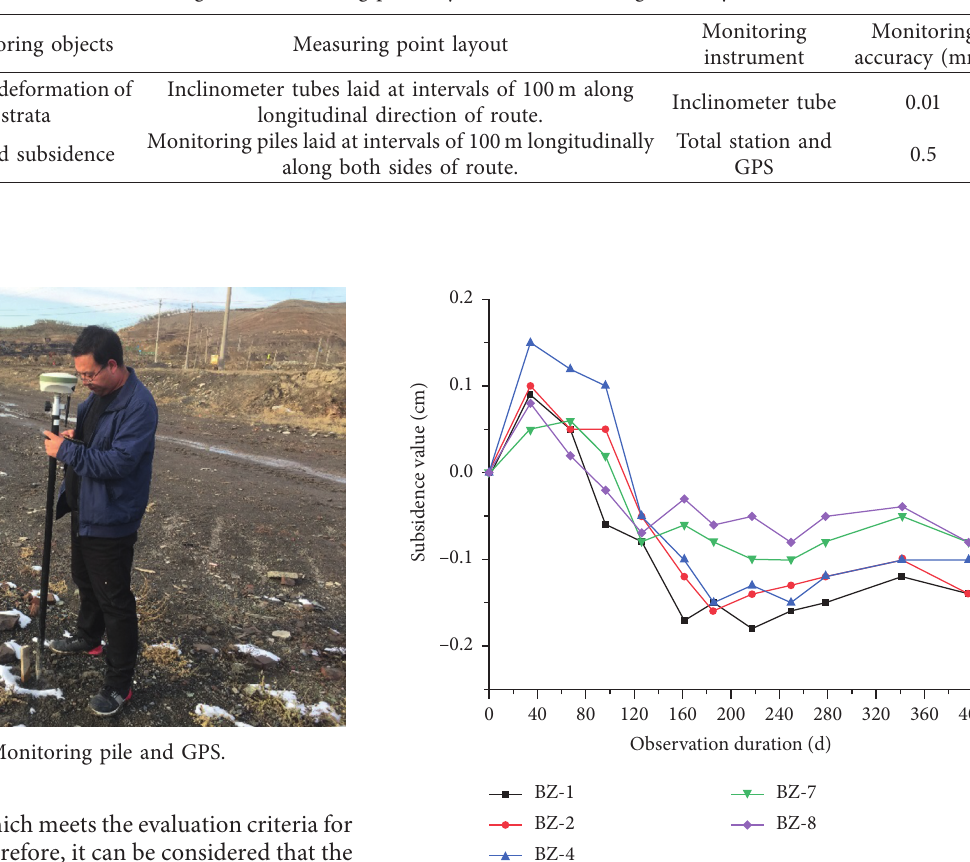
Figure 29: Ground subsidence